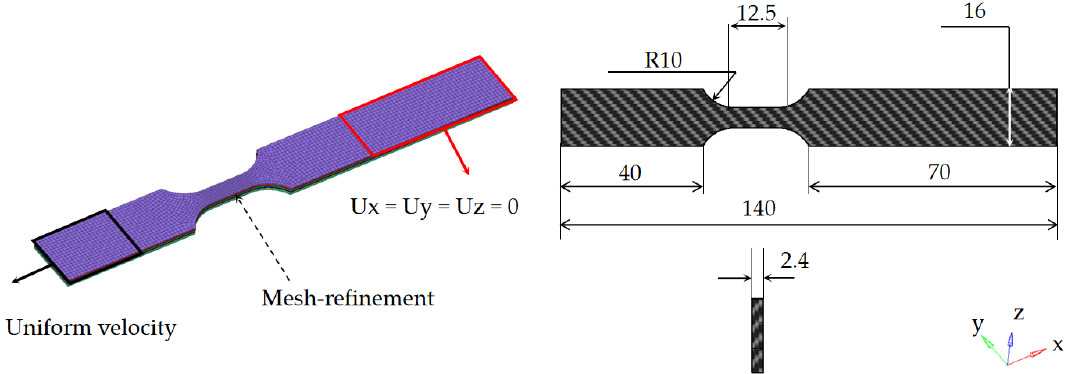
Figure 3. Finite element model.